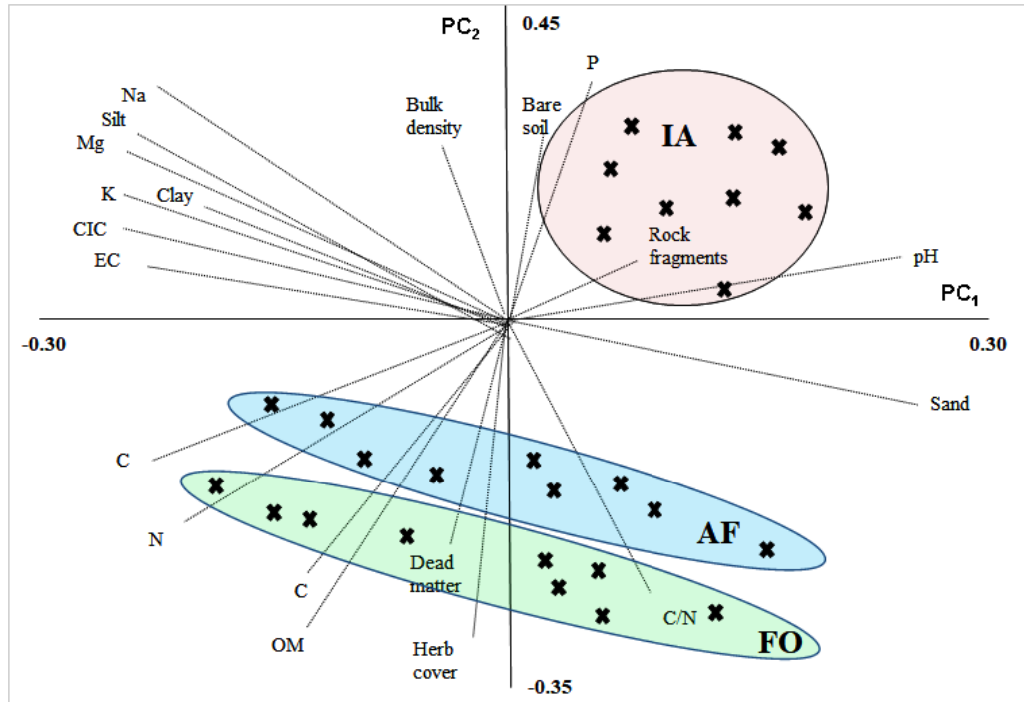
Figure 4. Principal component analysis applied to properties of soils subject to different land uses (AF: Abandoned Farmland; IA: Intensive Agriculture; FO: Forest) in the study area (Villamalea, Castilla La Mancha, SE Spain) (the ellipses represent the evident clusters achieved by coupling ANOVA and PCA and using land uses as factors).